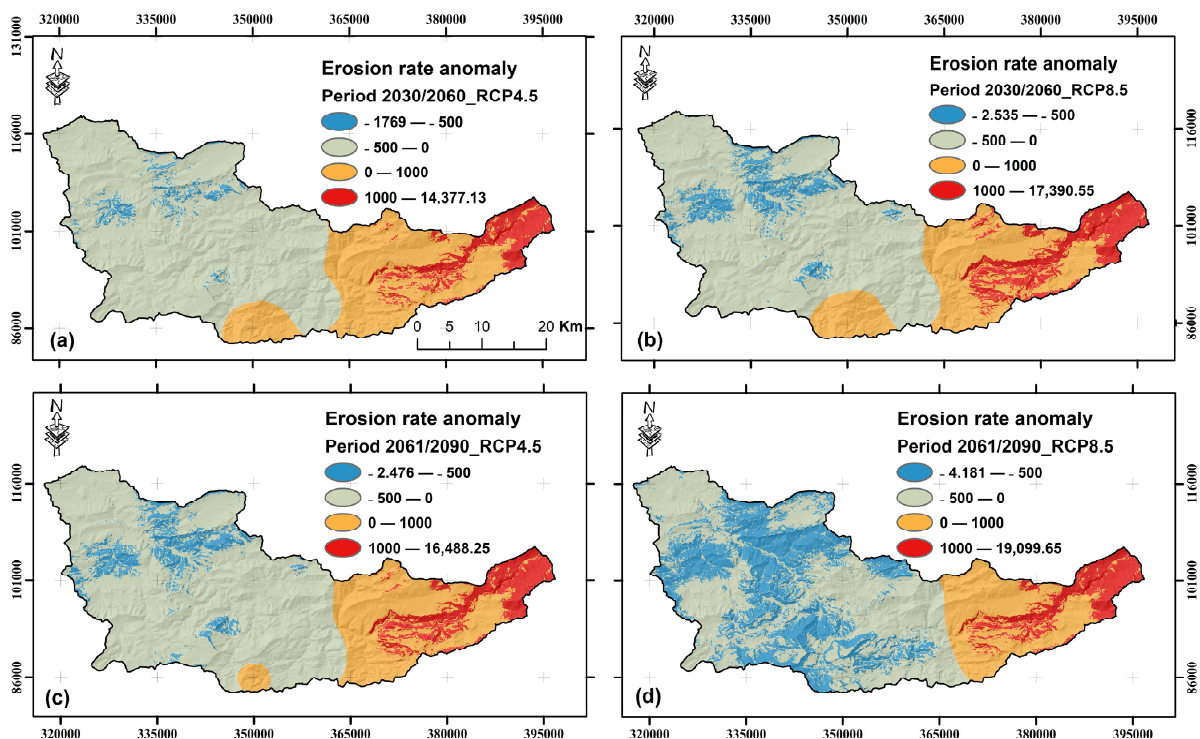
Figure 13. Anomaly of soil erosion rate relative to the baseline period (1976–2005) for the periods 2030–2060 and 2061–2090 under scenarios RCP4.5 and RCP8.5. ( a ) Period 2030–2060 RCP4.5, ( b ) period 2030–2060 RCP8.5, ( c ) period 2061–2090 RCP4.5, ( d ) period 2061–2090 RCP8.5.